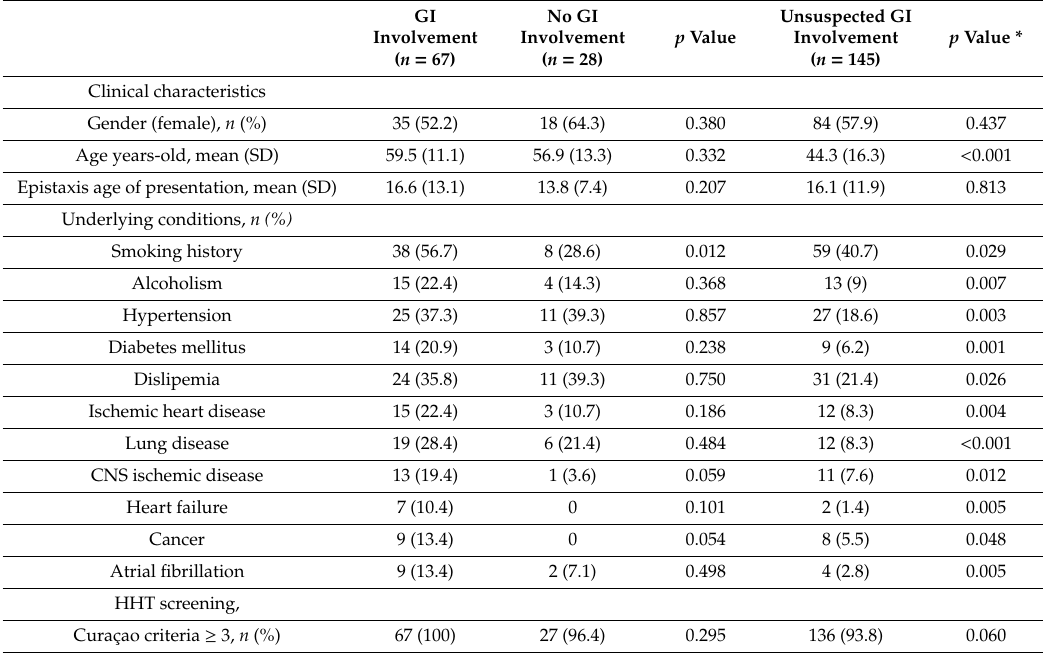
Table 1. Clinical characteristics and screening tests according to gastrointestinal involvement in 240 patients with hereditary hemorrhagic telangiectasia (HHT).